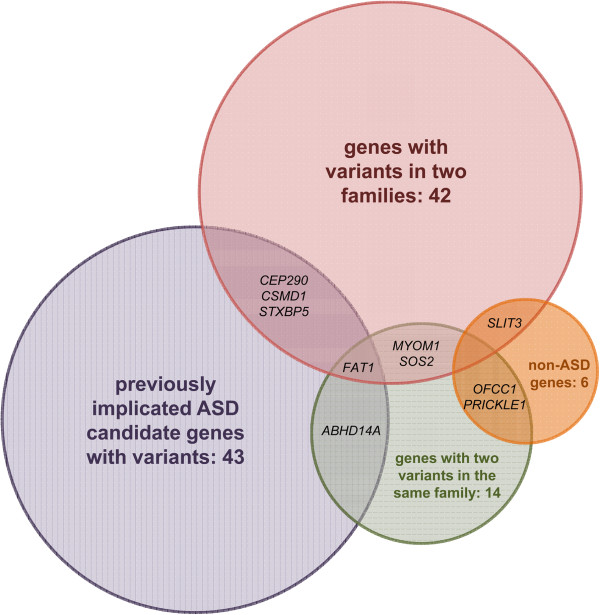
Diagram of genes of high interest. The area of each circle corresponds to the number of genes identified in one of four categories: genes previously implicated as ASD candidates, non-ASD genes that have been implicated in other neurodevelopmental and neuropsychiatric disorders, genes found to have damaging variants in more than one family, and genes that carry two damaging alterations in the same family. ASD, autism spectrum disorder.